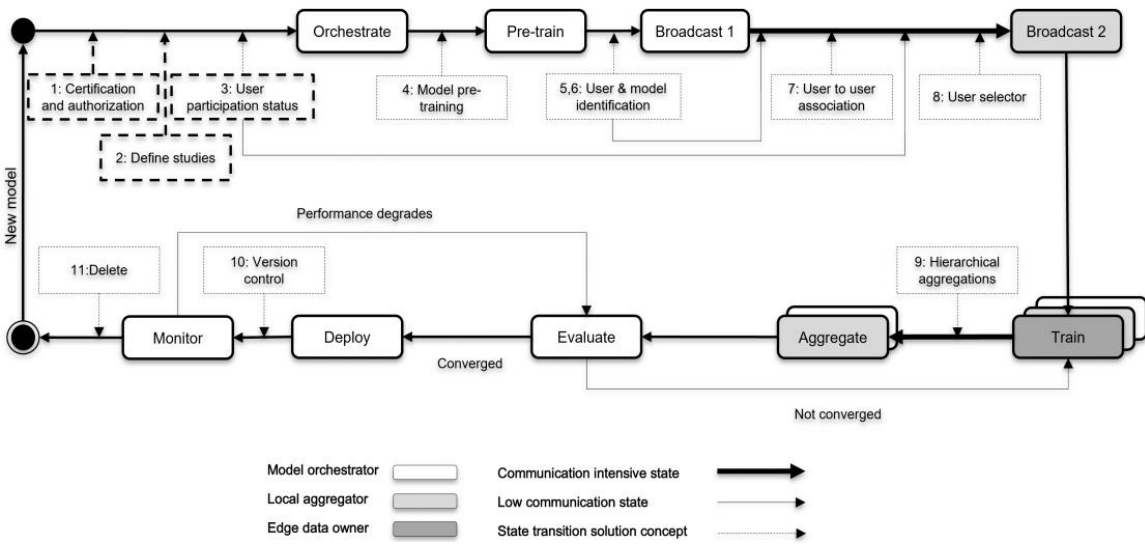
Figure 3. A model life cycle for the FL on hierarchy and hybrid models (patient-centered health care information systems) building on the current trust structures of health care systems—CareNetFL.